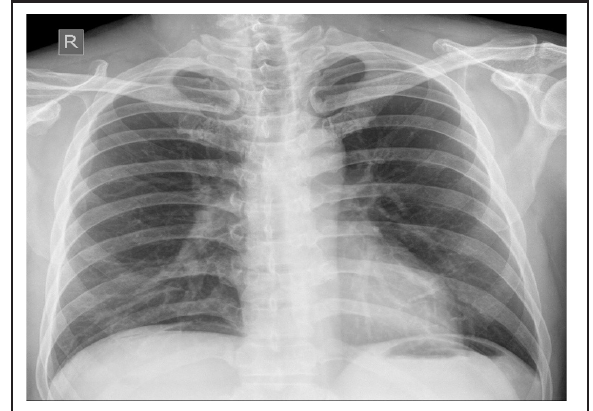
Figure 1. X-ray chest erect showing gas under both hemi-diaphragms.